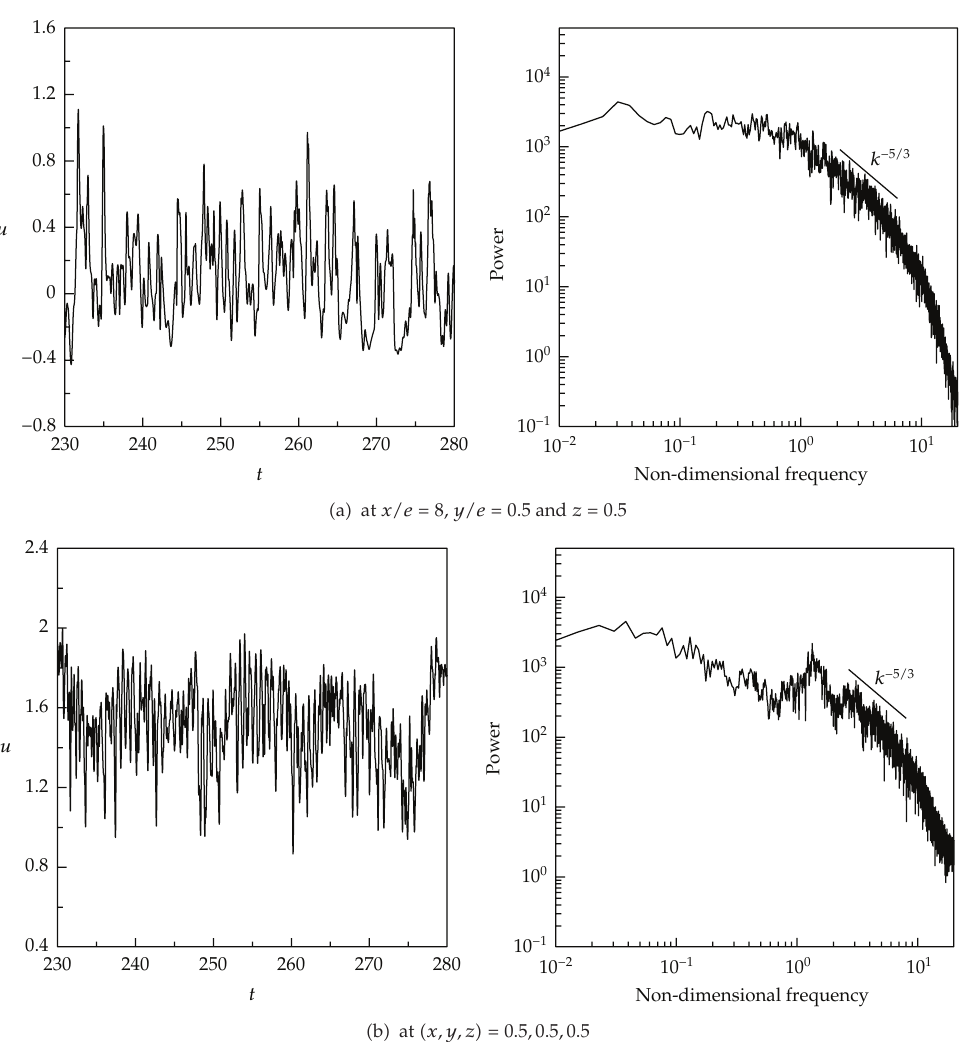
Figure 2: Time variation and power spectra of streamwise velocity at (cid:2) a (cid:3) downstream of the rib; and (cid:2) b (cid:3) center of the computational